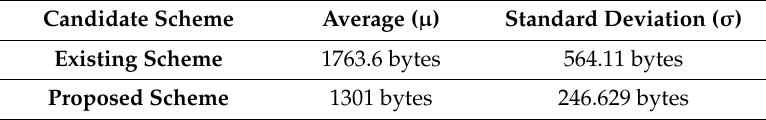
Figure 22. Comparison of response times for IVI resource control messages.